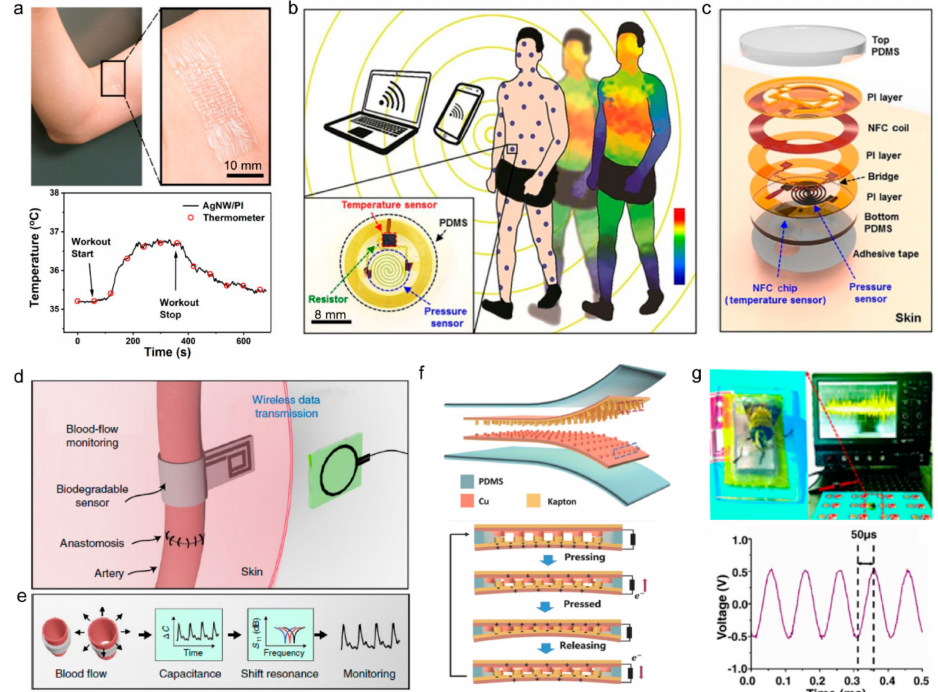
Figure 3. Physical sensors with wireless functions. ( a ) Top: photograph of AgNW / PI temperature sensor is attached to the skin near biceps. Bottom: temperature recorded by the temperature sensor and IR thermometer during biceps workout (Reproduced with permission [87]. Copyright